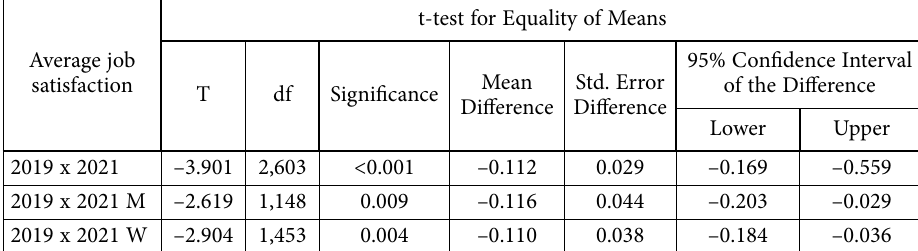
Table 3. T-test and P values for overall job satisfaction level and for both genders (source: own processing)